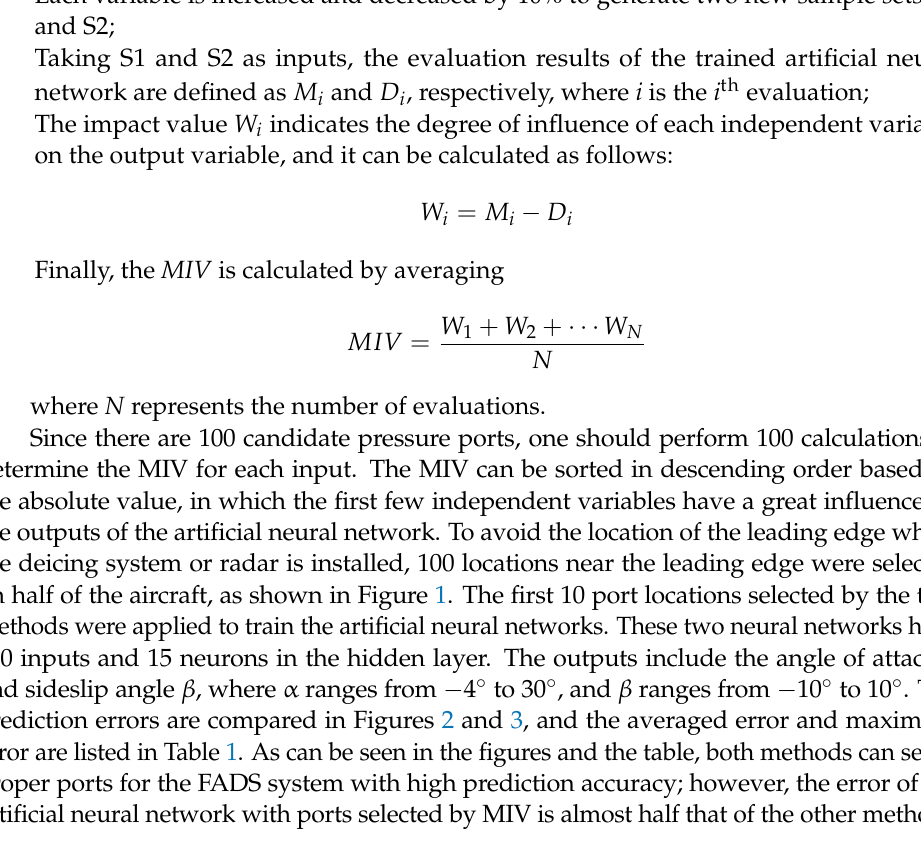
Table 1. The comparisons of the prediction